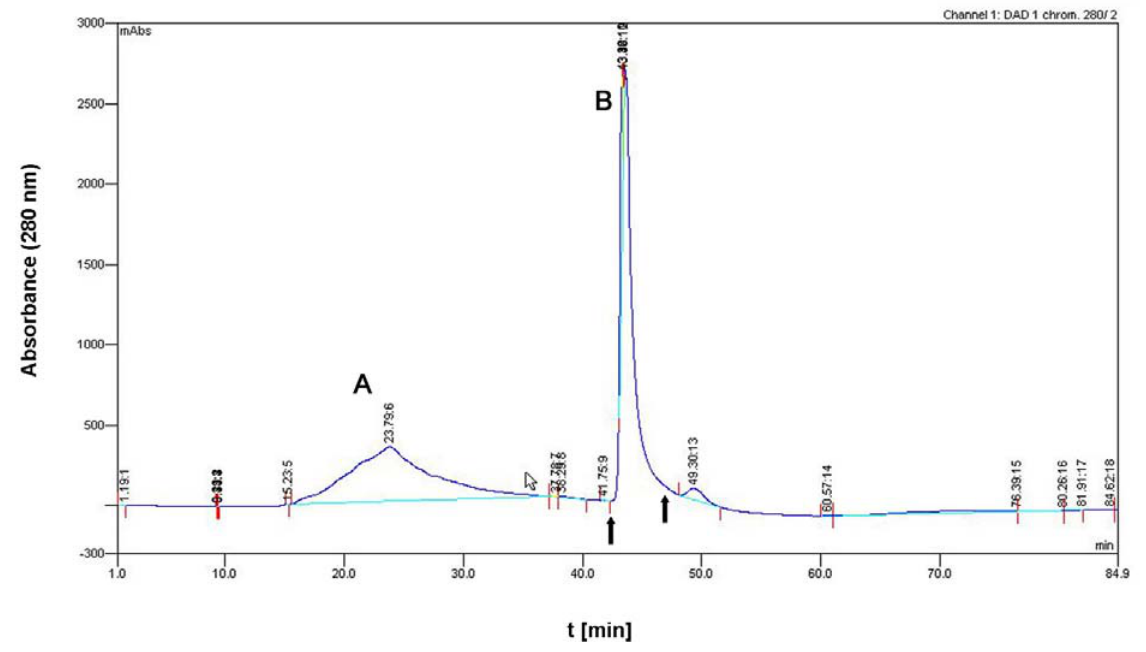
FIGURE 1. Purification of decorin from the conditioned media of human skin fibroblasts by DEAE-HPLC chromatography. Media were collected from human skin fibroblast after 3–4 days of culture and prepurified on a DEAE-trisacryl M ion exchange column. After dialysis, decorin was purified by HPLC-DEAE chromatography using a continuous NaCl concentration gradient. Decorin began to elute at about 42 min (B, left arrow) and reached a peak at 43.38 min, whereas heparan sulfate proteoglycans were already eluted between 15 and 35 min (A). Proteins were detected at 280 nm using a diode array detector. Flow rate = 1.2 ml/min. Arrows denote the decorin-containing peak.